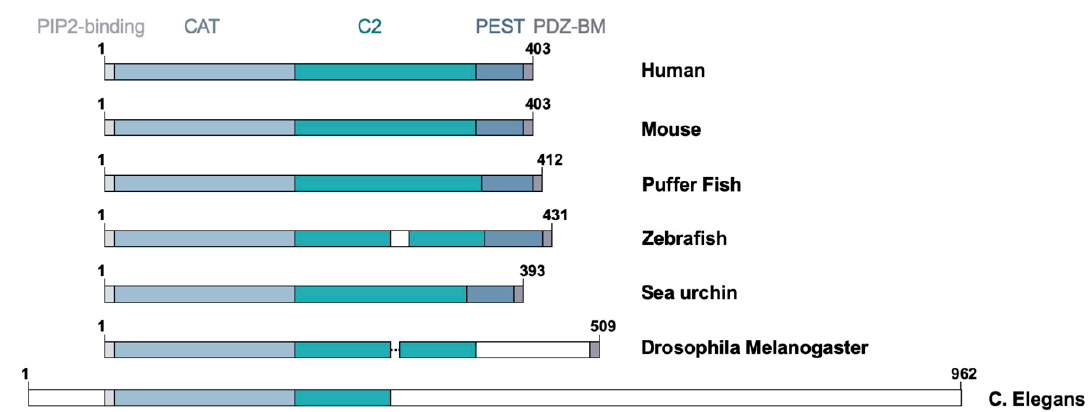
Figure 2. Functional domains in PTEN are evolutionarily conserved. Schematic representations of the five conserved domains in the species are indicated. Numbers indicate amino acid positions. Clear box, distinct sequence; dotted line, gap.